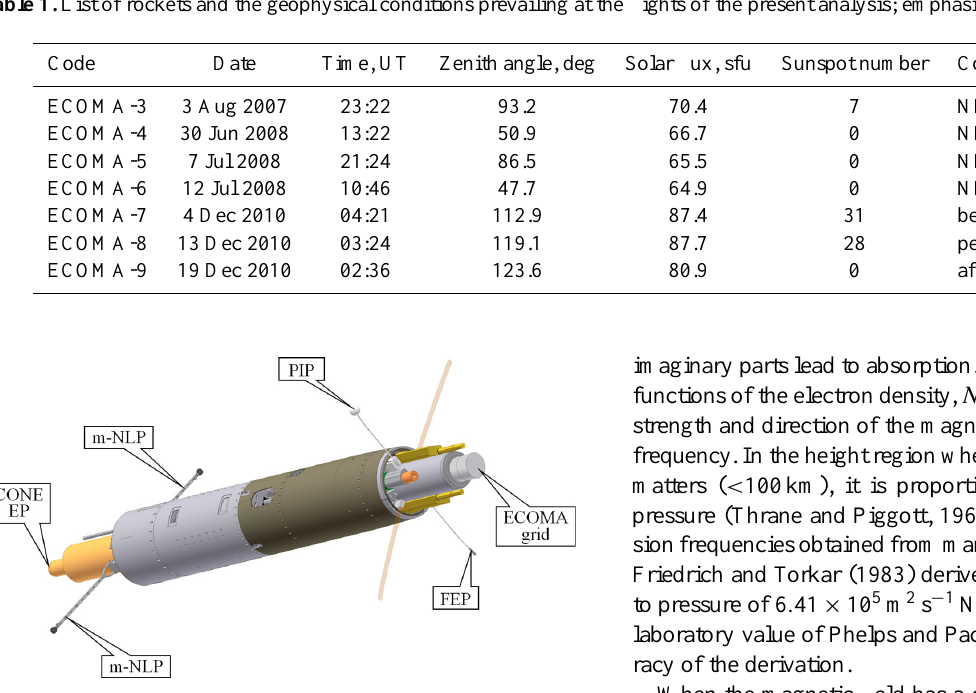
Table 1. List of rockets and the geophysical conditions prevailing at the flights of the present analysis; emphasis is on flights 7 to 9.